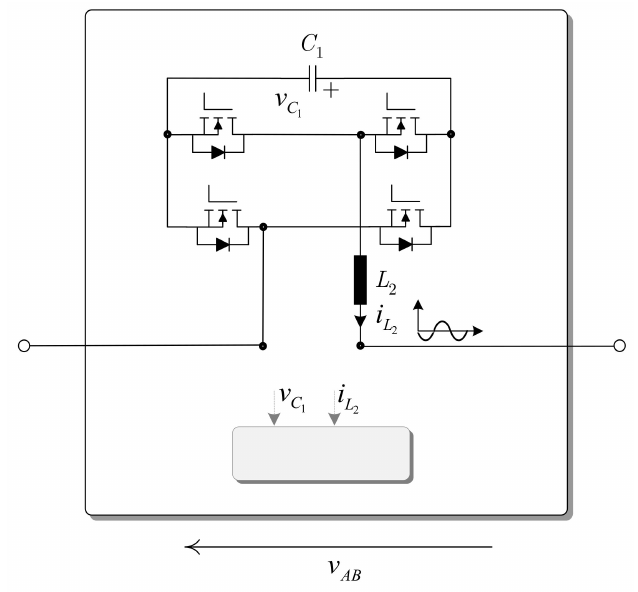
Figure 2. One implementation of the variable active inductor for the DC link of the motor-drive ap- plications.